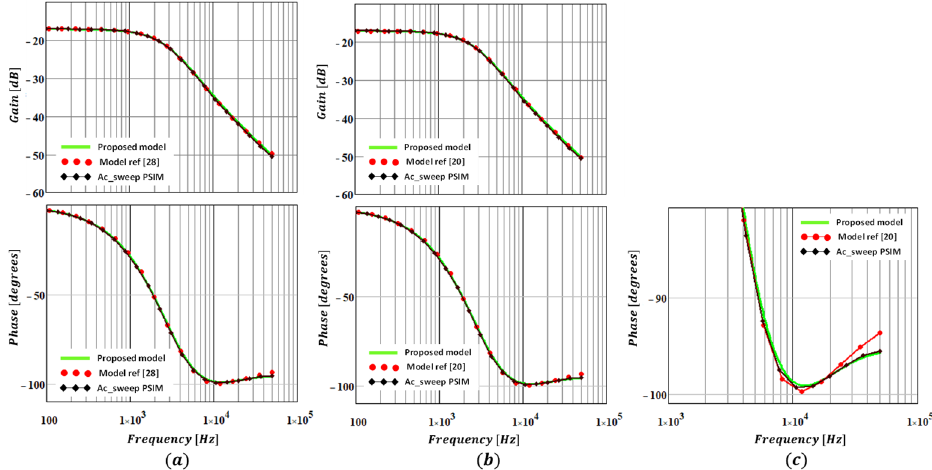
Figure 13. Comparison of the frequency response of the audio-susceptibility transfer function for a power level of 90 W. ( a ) Proposed small-signal model vs. small-signal model presented in [28]. ( b ) Proposed small-signal model vs. small-signal model presented in [20]. ( c ) Phase zoom.